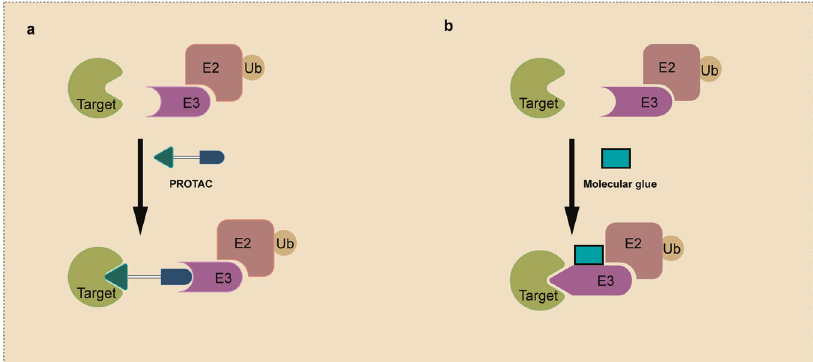
Fig. 4 Schematic representation of PROTAC and Molecular Glue. a A PROTAC molecule consists of an E3 ligase-targeting ligand, a linker, and a POI-binding ligand. It simultaneously binds to the POI and the E3 ubiquitin ligase, and induces the polyubiquitination and degradation of the POI. b Molecular glue induces the interaction between a POI and an E3 ubiquitin ligase via binding to the E3 ubiquitin ligase, as illustrated, or the POI. Relative to PROTAC molecules, molecular glues do not have a linker and have a lower